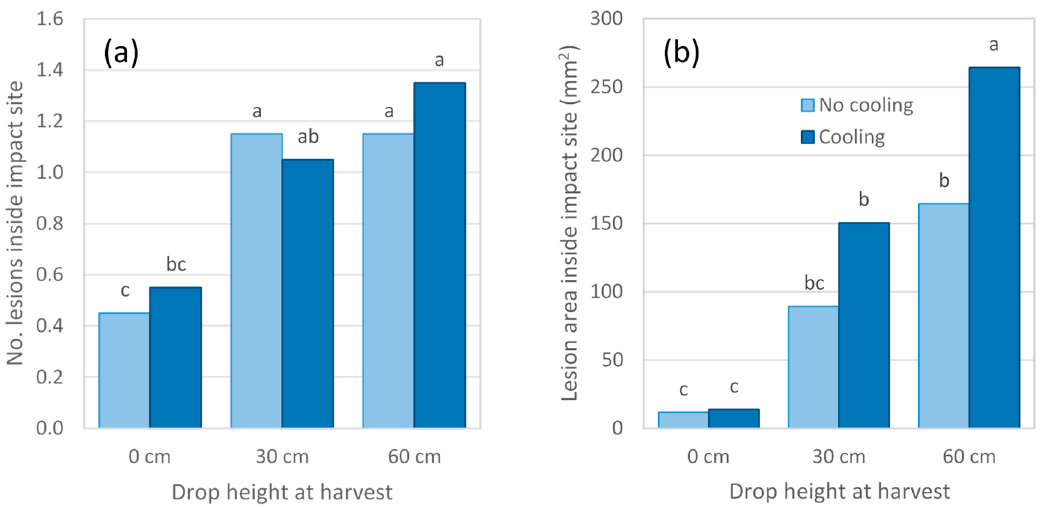
Figure 6. Lesion number ( a ) and lesion area ( b ) inside the impact site in ‘Hass’ avocado fruit from Experiment 6 assessed at soft-ripe stage. Fruit were subjected to drop heights of 0, 30 or 60 cm on day of harvest, held overnight at ambient conditions and either cooled to 5 °C (cooling) or held at 20 °C (no cooling) for 24 h prior to ripening. Means that do not share a letter are significantly different ( p < 0.05) according to Fisher’s LSD test.